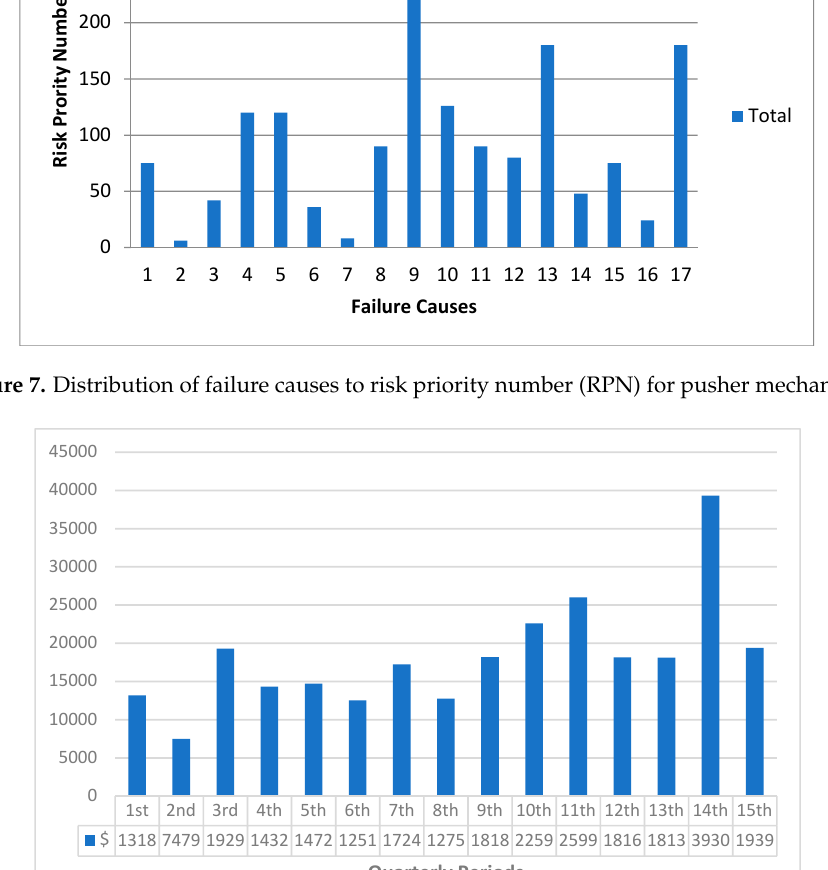
Table 7. Computation of FMEA for the plunger mechanism.